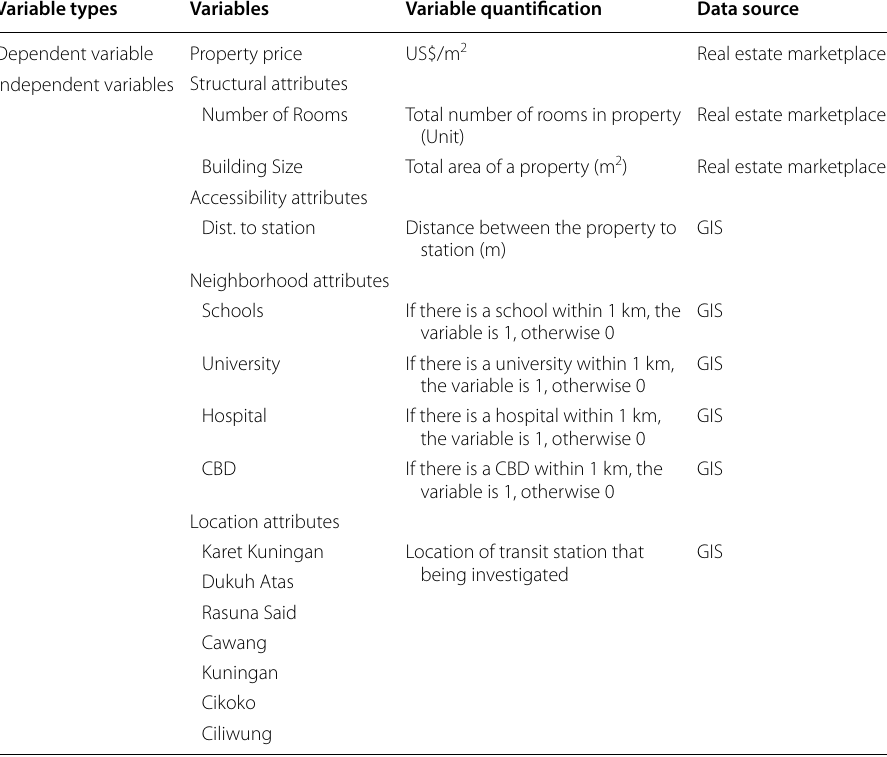
Table 2 Variables measurement Variable